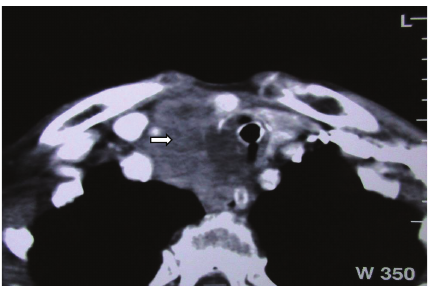
Figure 1: Computed tomography showing the cervical CASTLE tumour surrounding the trachea anterolaterally and invading the thyroid gland.